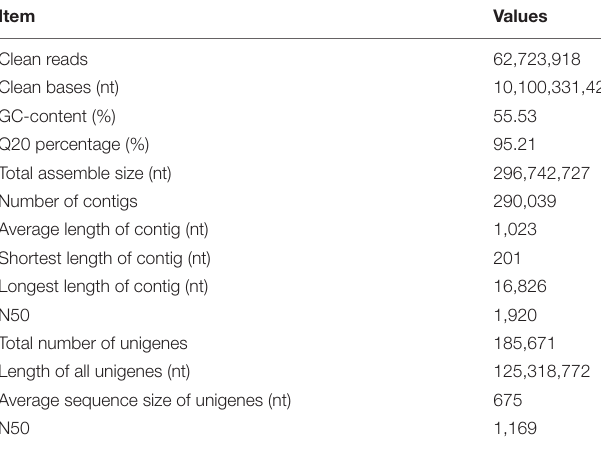
TABLE 1 | Summary of sequencing and de novo